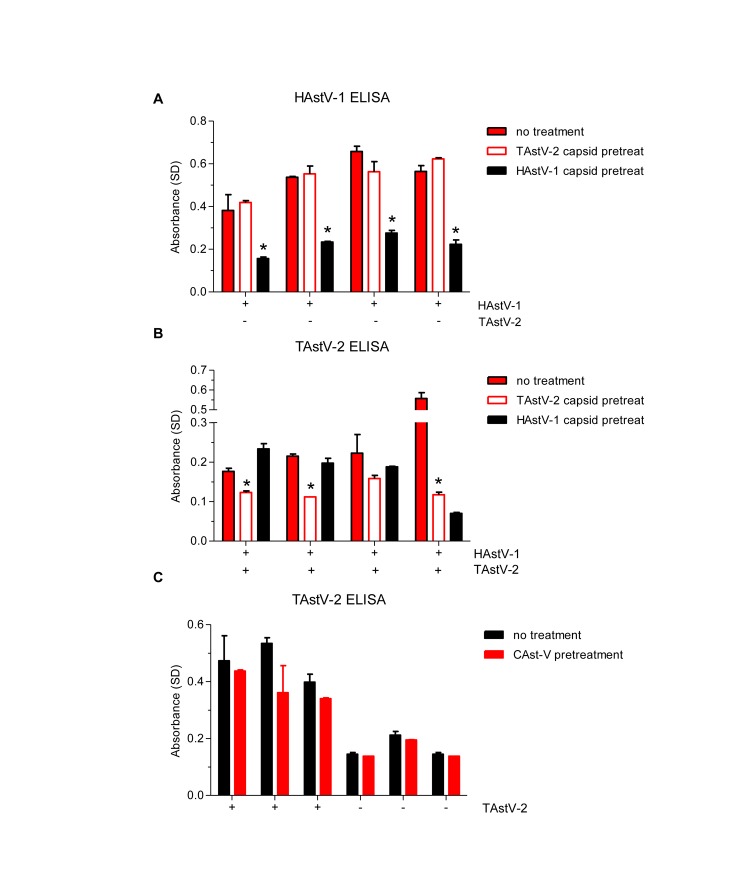
Specificity of the human sera to HAstV-1 and TAstV-2 capsid proteins.A) HAstV-1 positive sera were pre-incubated with PBS (no treatment) or HAstV-1 or TAstV-2 capsid proteins and binding to HAstV-1 capsid protein assessed by ELISA. B) TAstV-2 positive sera were pre-incubated with PBS (no treatment) or HAstV-1 or TAstV-2 capsid proteins and binding to TAstV-2 capsid protein assessed by ELISA. C) TAstV-2 positive and negative sera were pre-incubated with PBS (no treatment) or chicken astrovirus and binding to TAstV-2 capsid protein assessed by ELISA. A plus sign denotes serum sample was positive for indicated virus, and a minus sign denotes serum sample was negative for the indicated virus. Samples were tested in duplicate and data shown are mean values; error bars indicate SD. *p<0.05.